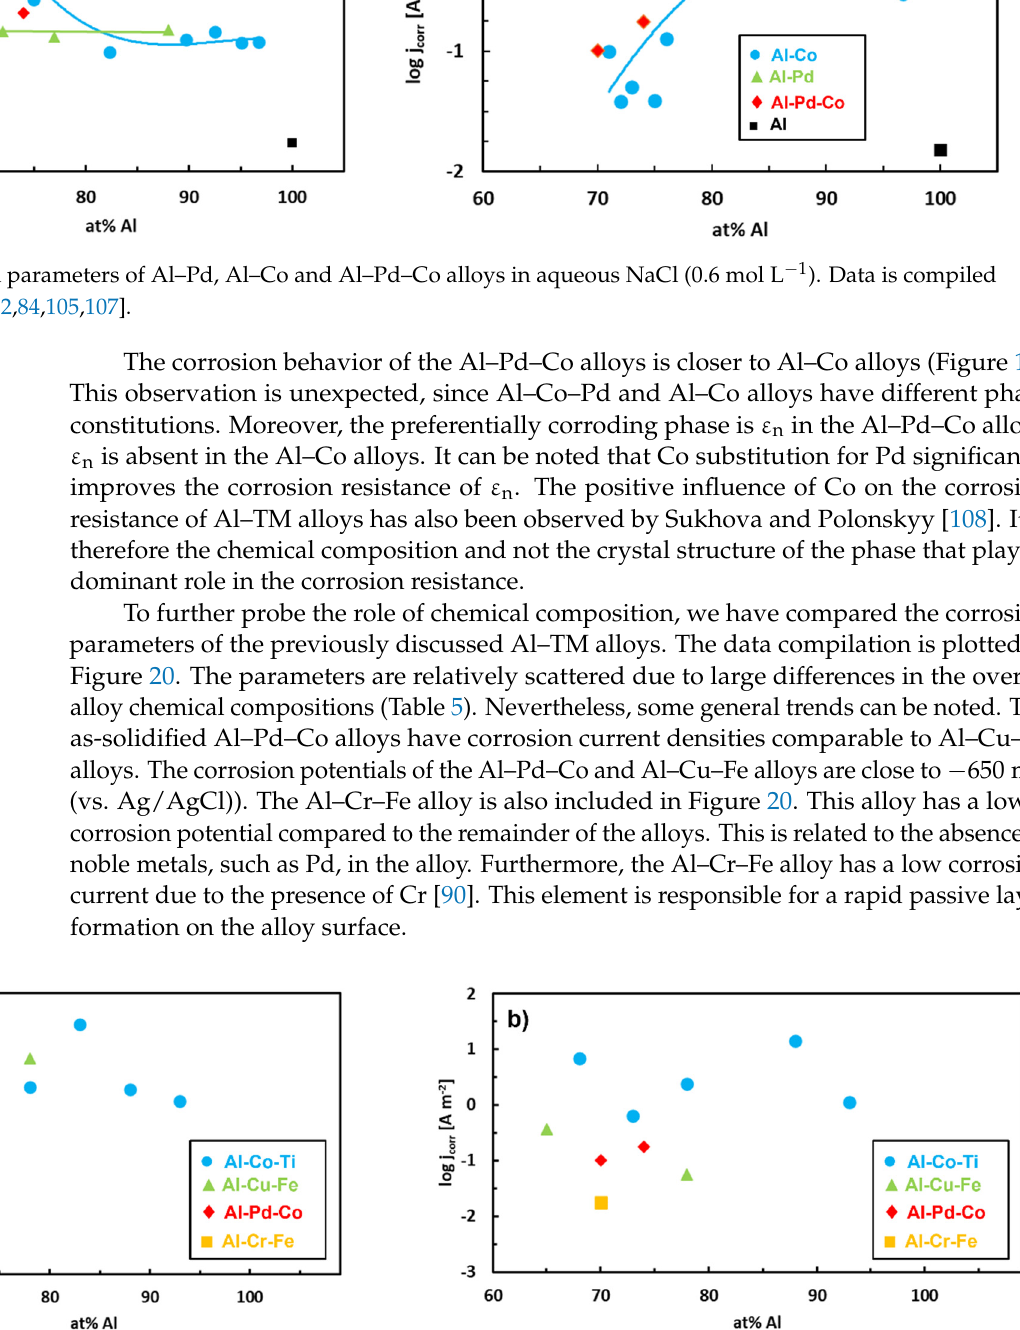
Figure 20. Corrosion parameters of ternary Al–TM alloys in aqueous NaCl (0.6 mol L − 1 ). Data is compiled from references [90,107,109,110].